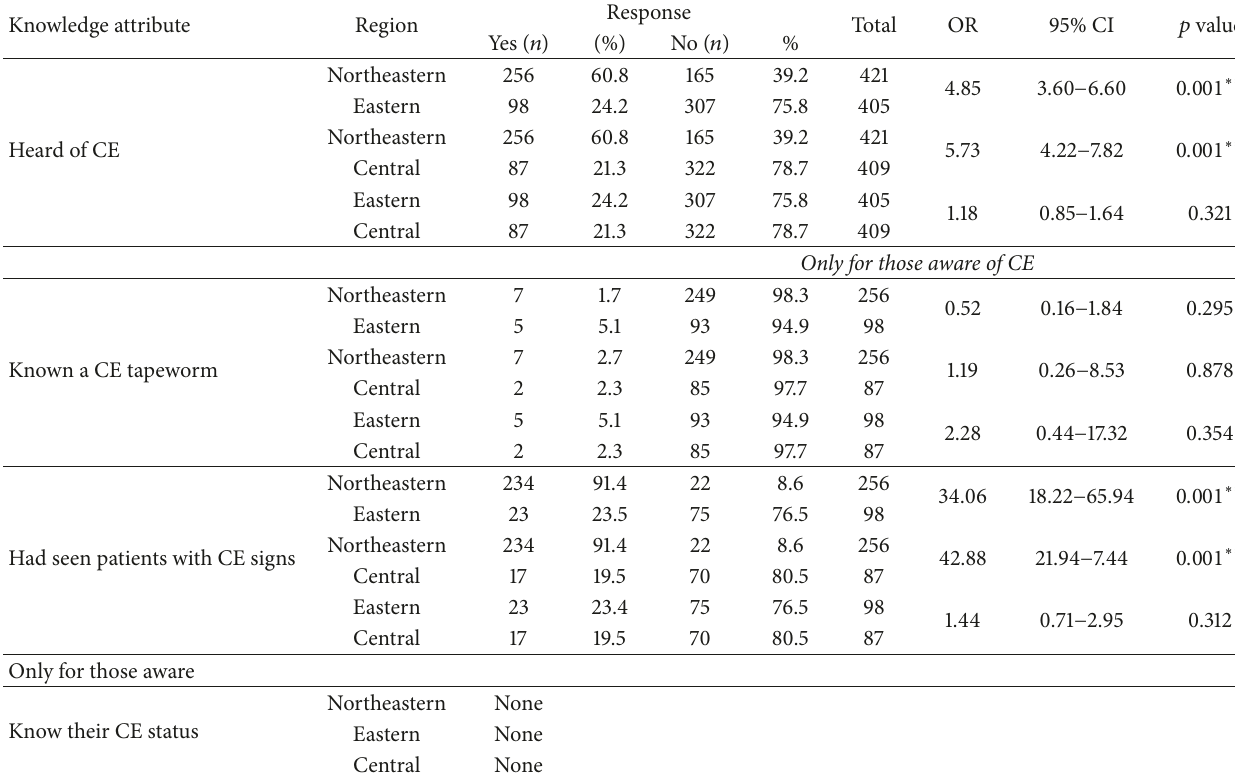
Table 2: Knowledge level of communities about CE infection in